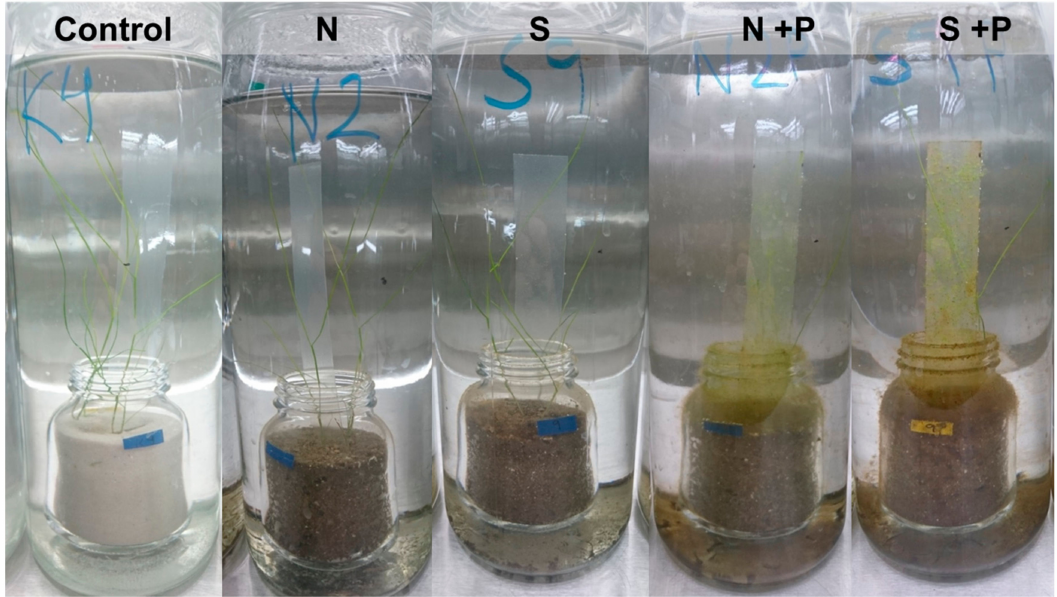
Figure 3. Experimental setup of the growth experiment with submerged macrophytes ( Stuckenia pectinata ) and periphyton on artificial substrates in five treatments (control: Sand, N, S: Sediments of north-eastern and south-western shore, respectively, + P: With phosphorus addition) with six replicates